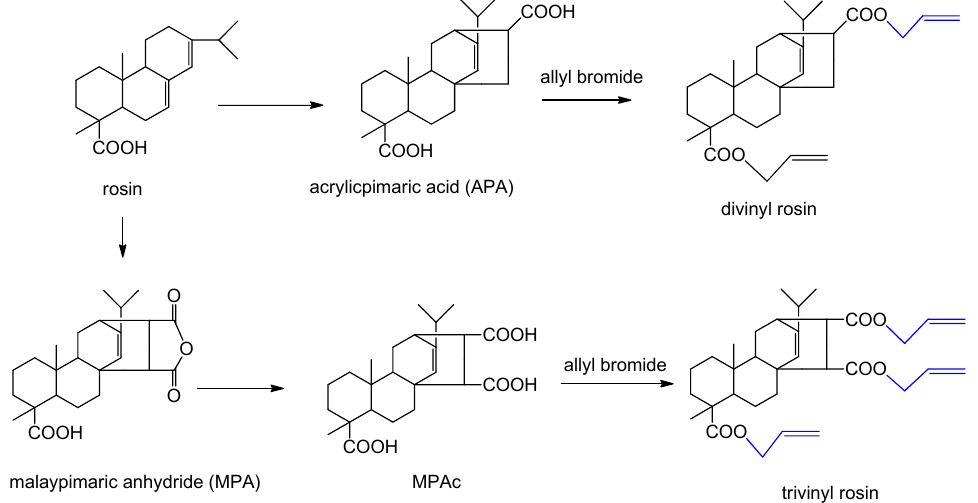
Figure 11. Synthesis of divinyl rosin and trivinyl rosin from rosin acid [61].